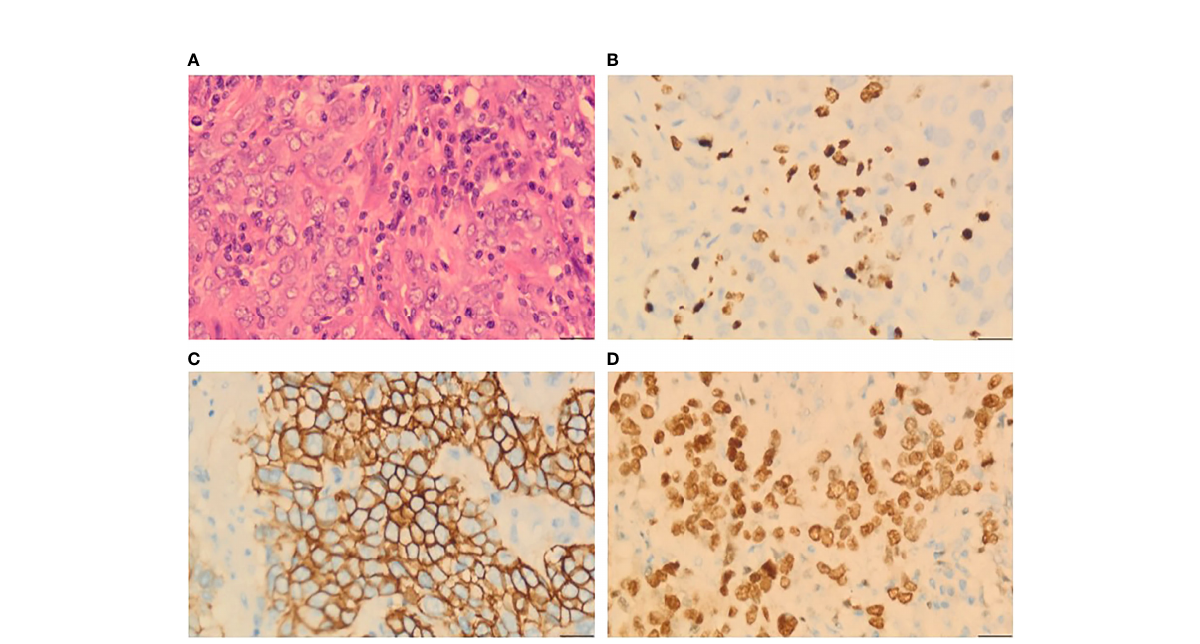
FIGURE 3 Histopathological analysis from a splenic lesion. (A) Microphotography showing poorly differentiated tumor cells (H&E, ×40). (B) 30% positive immunostaining for Ki67 (H&E, ×40). (C) Diffuse and strong positive for CerbB2 (H&E, ×40). (D) Diffuse strong nuclear staining for GATA3 (H&E,